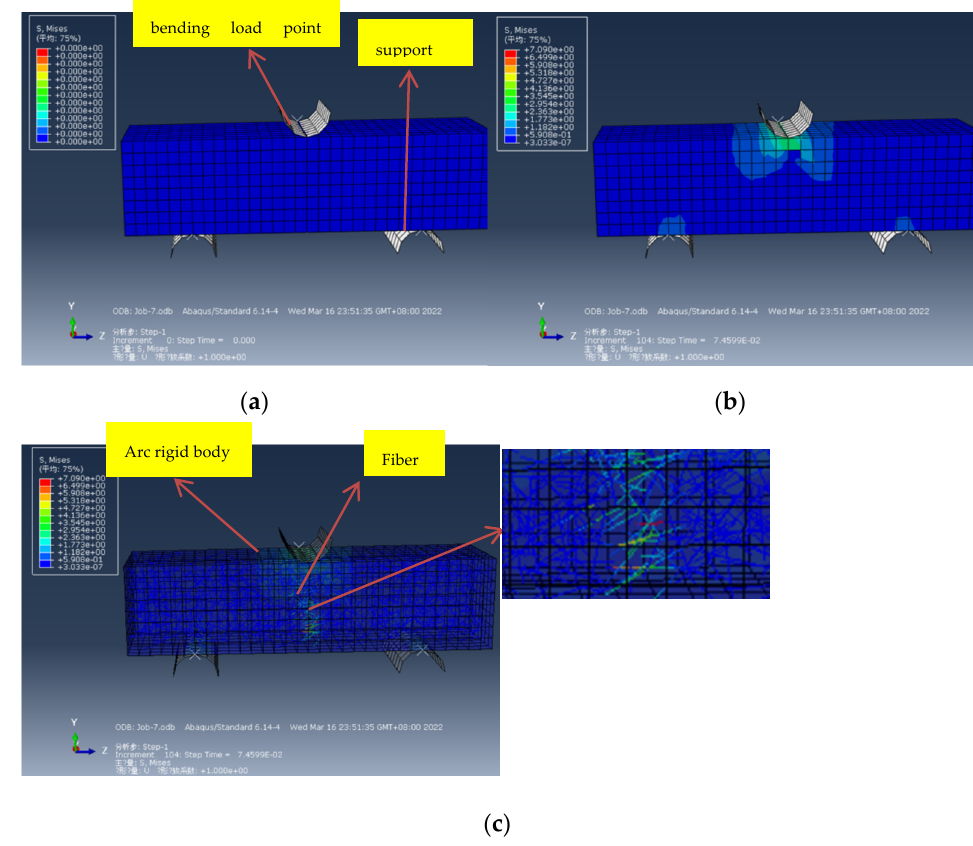
Figure 14. Bending resistance test: ( a ) Simulation stress cloud diagram before force; ( b ) Stress cloud diagram after force; ( c ) ABAQUS simulated stress perspective cloud diagram.